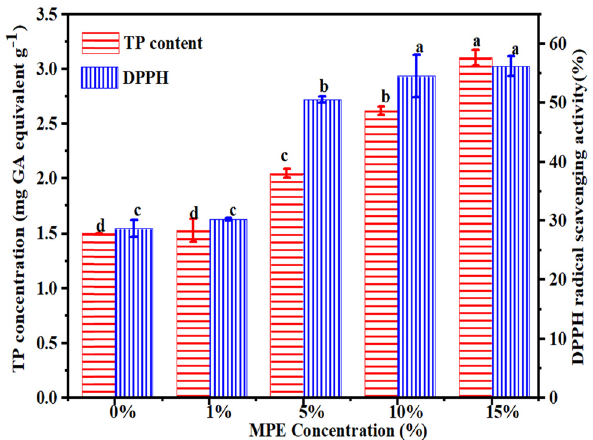
Figure 1: TP content and DPPH radical scavenging activity of the SPI fi lms with and without MPE. All data are expressed as mean values ± standard deviation ( SD ) . Di ff erent letters indicated signi fi cant di ff erences ( P < 0.05 )